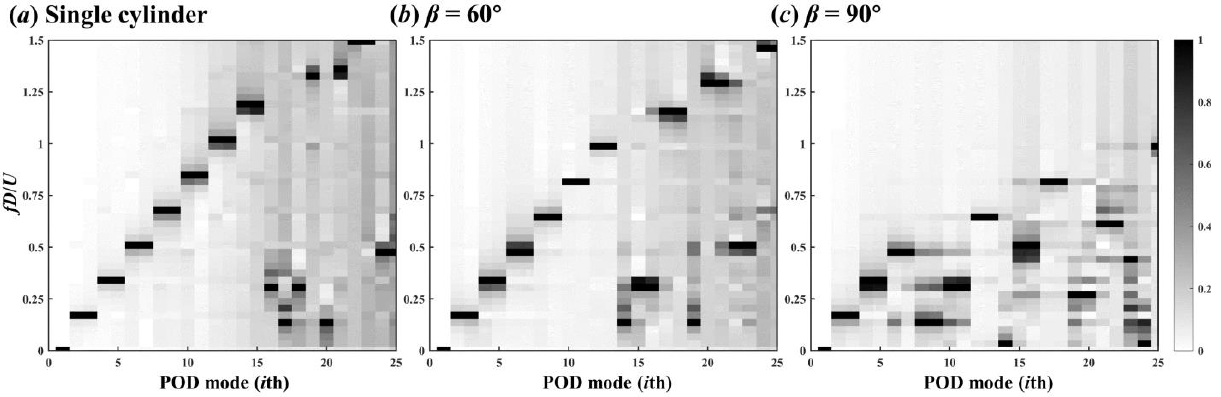
Figure 13. Frequency peak distribution of POD modes for the cases of the single cylinder ( a ) and two crossing cylinders in 60° ( b ) and 90° ( c ) arrangements.